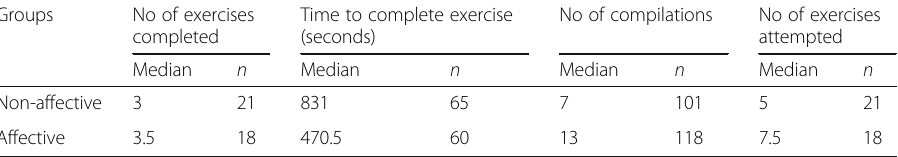
Table 1 Descriptive Statistics for determinants of learning achievement